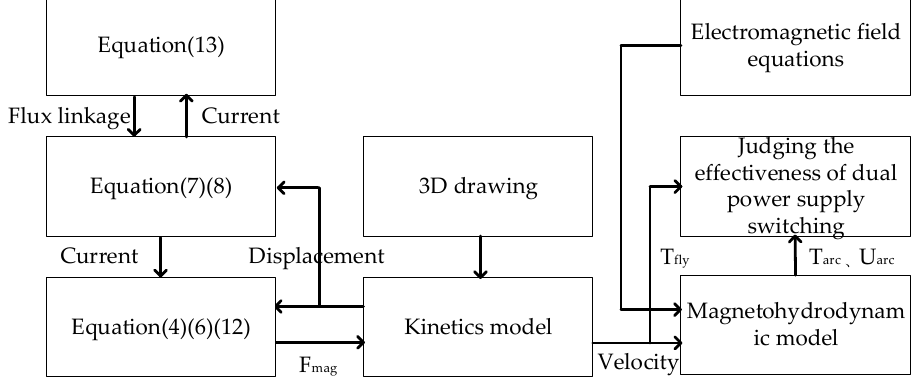
Figure 6. Simulation framework.